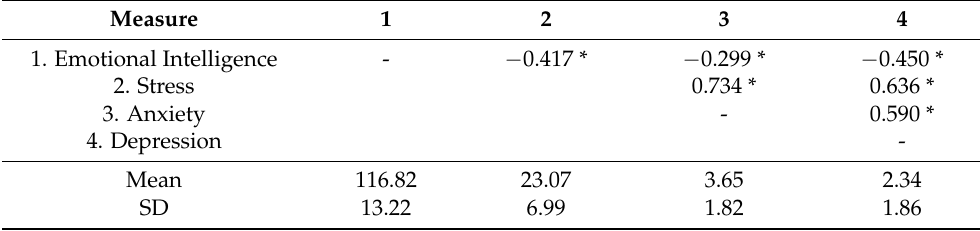
Table 2. Zero-order correlation matrix of psychological variables. Measure